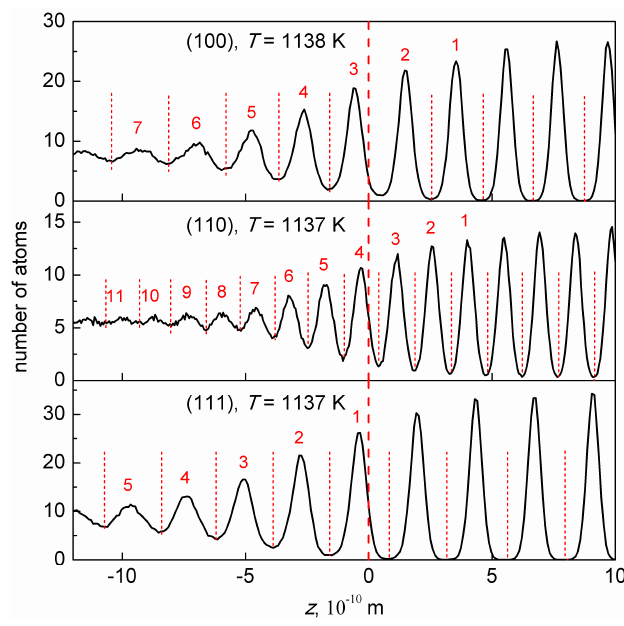
Figure 1. Distributions of atoms along the z direction at the (100), (110), and (111) interfaces. Although the 2 ‐ D density map provides a direct observation of atom arrangement, it falls short of revealing weak in ‐ plane ordering in layers far from the crystal. To better show the short ‐ range order at the interface, the 2 ‐ D density map is then utilized to calculate the 2 ‐ D structure factor, which is defined as